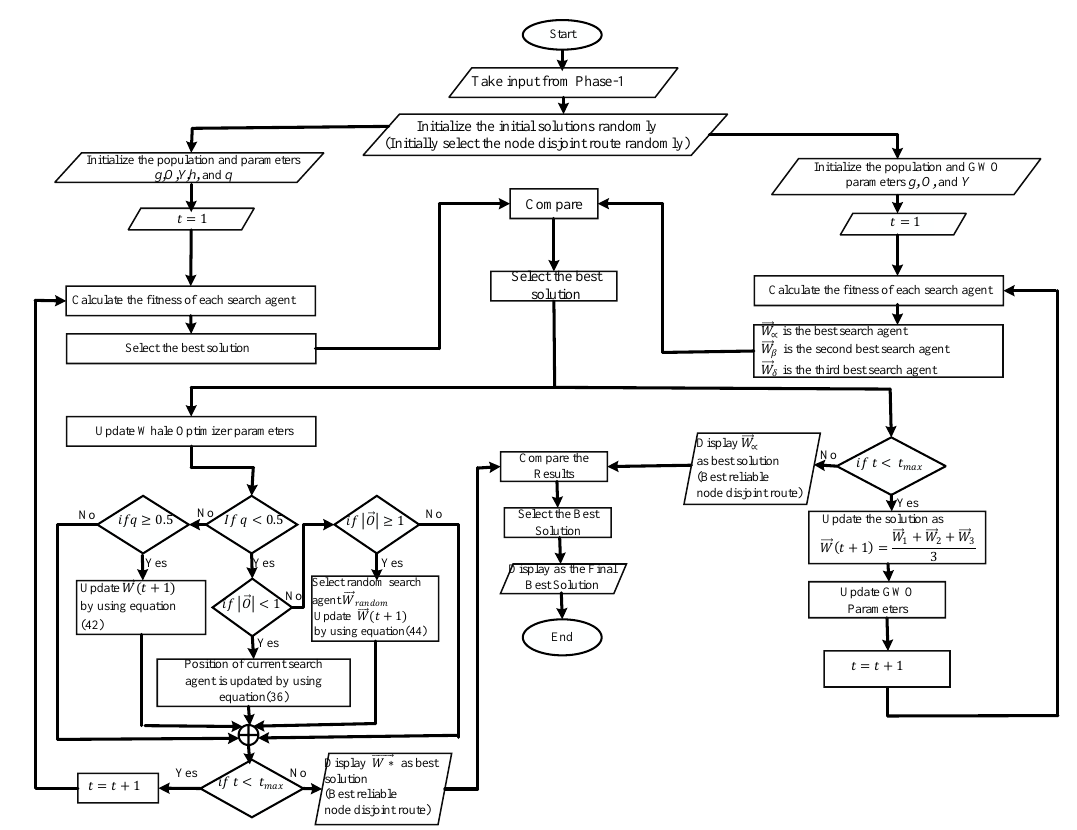
Figure 3. Integrated view of the proposed optimization framework, consisting of Phase 2. In the EH-WSN, the total number of SNs is | SN set | . Each source node is